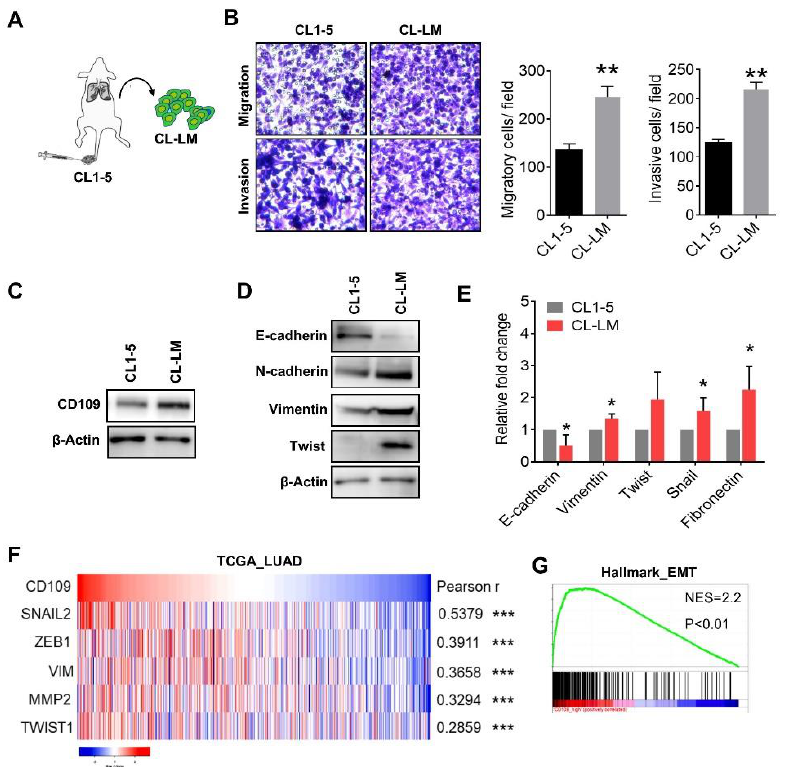
Figure 1. Elevation of CD109 is associated with the epithelial-to-mesenchymal transition (EMT) in metastatic lung adenocarcinoma cells. ( A ) Illustration of the generation of lung metastatic CL-LM cells. Parental CL1-5 lung adenocarcinoma cells were intravenously injected into the tail vein of NOD/SCID mice for 60 days. Metastatic CL-LM cells were isolated from tumor nodules of mice lungs. The detailed methodology is described in “Materials and Methods”. ( B ) Comparisons of the capabilities of migration and invasion between parental CL1-5 and metastatic CL-LM cells. Tumor migration and invasion were evaluated by a transwell analysis. Pictures were taken at 200× magnification. Data are the mean ± SD. * p < 0.05; ** p < 0.01, as determined by an unpaired t -test. ( C , D ) Western blot analysis of CD109 and EMT protein markers in CL1-5 and CL-LM cells. ( E ) Real-time PCR analysis of EMT gene expressions in CL1-5 and CL-LM cells. ( F ) Heatmap plot of transcriptome levels of CD109 and EMT-related genes in TCGA lung adenocarcinoma patients (TCGA_LUAD). Associations of transcriptome levels between CD109 and EMT-related genes were analyzed by Pearson correlations. * p < 0.05; ** p < 0.01; *** p < 0.001. ( G ) Enrichment plot between CD109 and the EMT signature from a Hallmark gene set in lung cancer patients using GSEA. NES, net enrichment score.